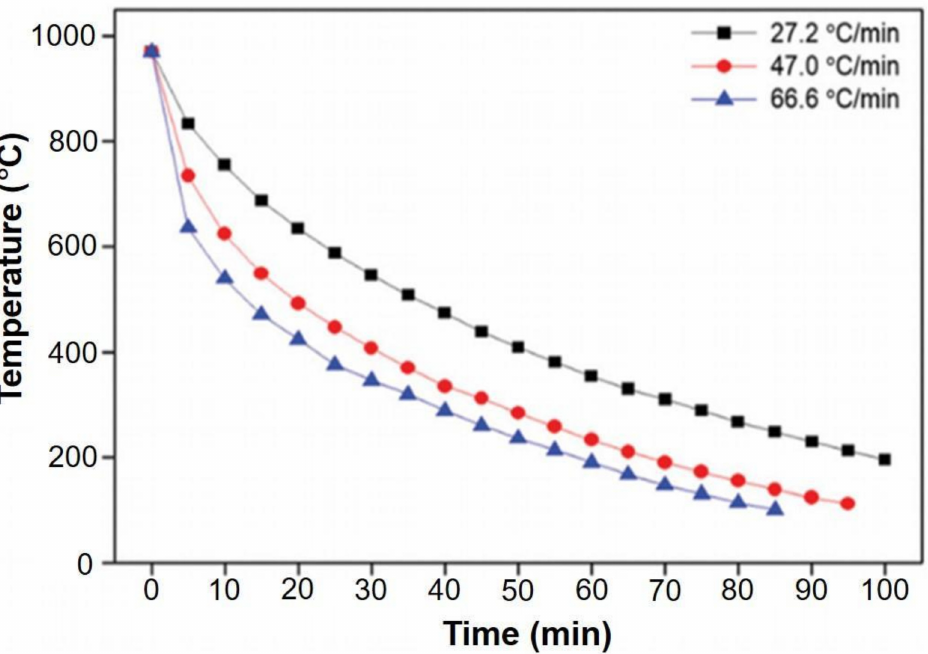
Figure 13. Cooling rate profiles of a CVD-MG. The initial cooling rates were estimated from the gradient between 0 and the first 5 min and were indicated in the upper-right part. Reprinted with permission from ref.